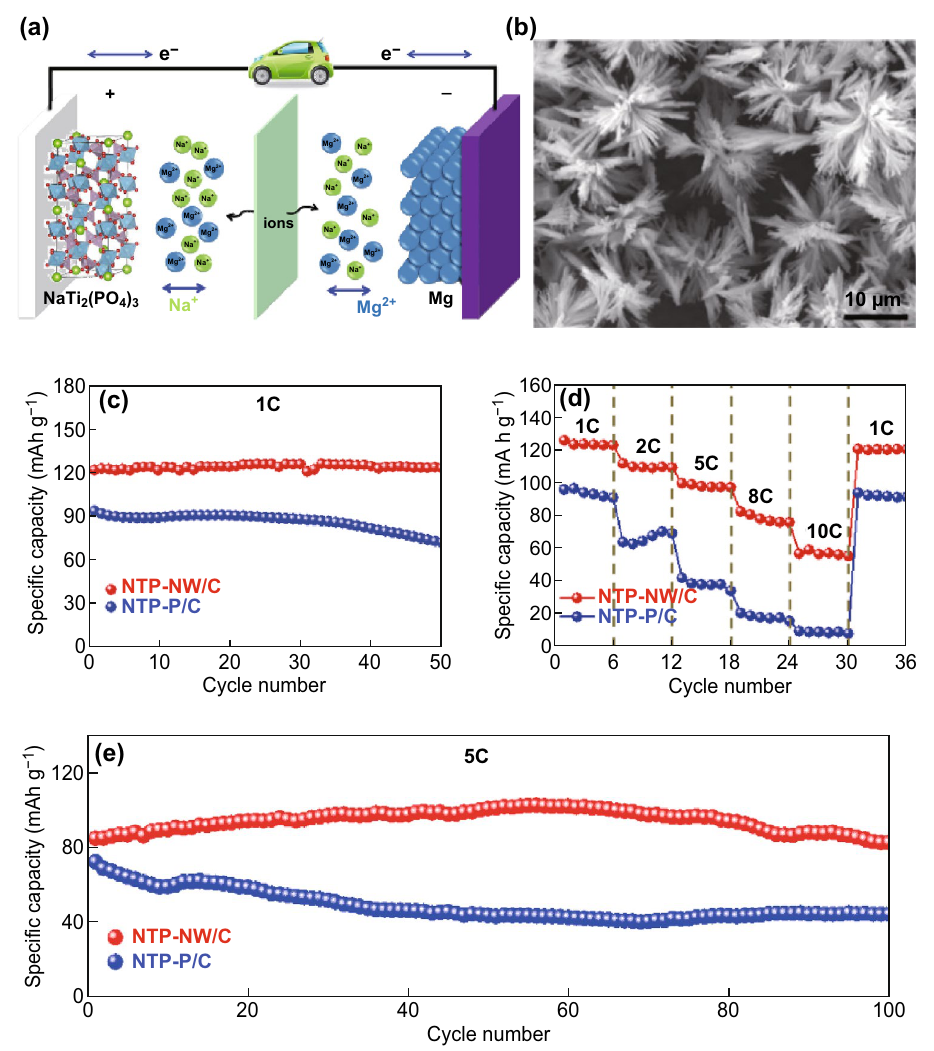
Fig. 13 a Schematic illustration of the Mg–Na hybrid battery in this work. b FESEM image of NTP-NW/C. c Cycling performances of NTP- NW/C and NTP-P/C at 1 C. d Rate performances of NTP-NW/C and NTP-P/C. e Cycling performances of NTP-NW/C and NTP-P/C at 5